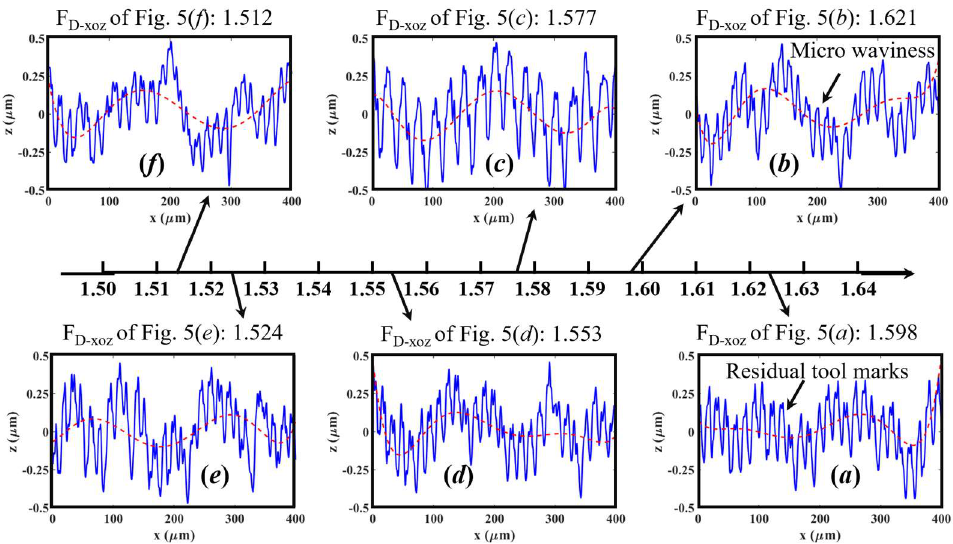
Figure 10. The cross-sectional contours of KDP surfaces shown in Figure 5 perpendicular to the feed direction and the corresponding 2D fractal dimension ( F D ). The red dash lines are the fitted curves through cubic polynomials.